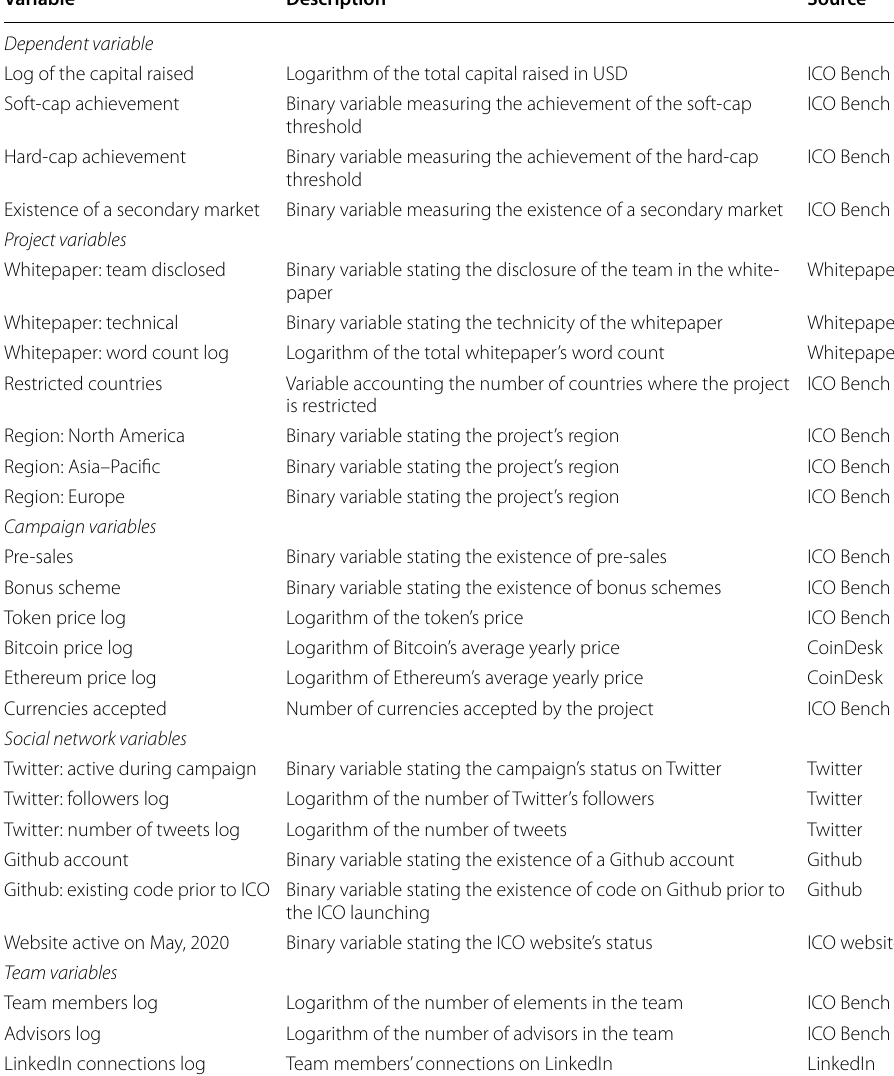
Table 1 Variable description Variable Description Source Dependent variable Log of the capital raised Soft-cap achievement Hard-cap achievement Existence of a secondary